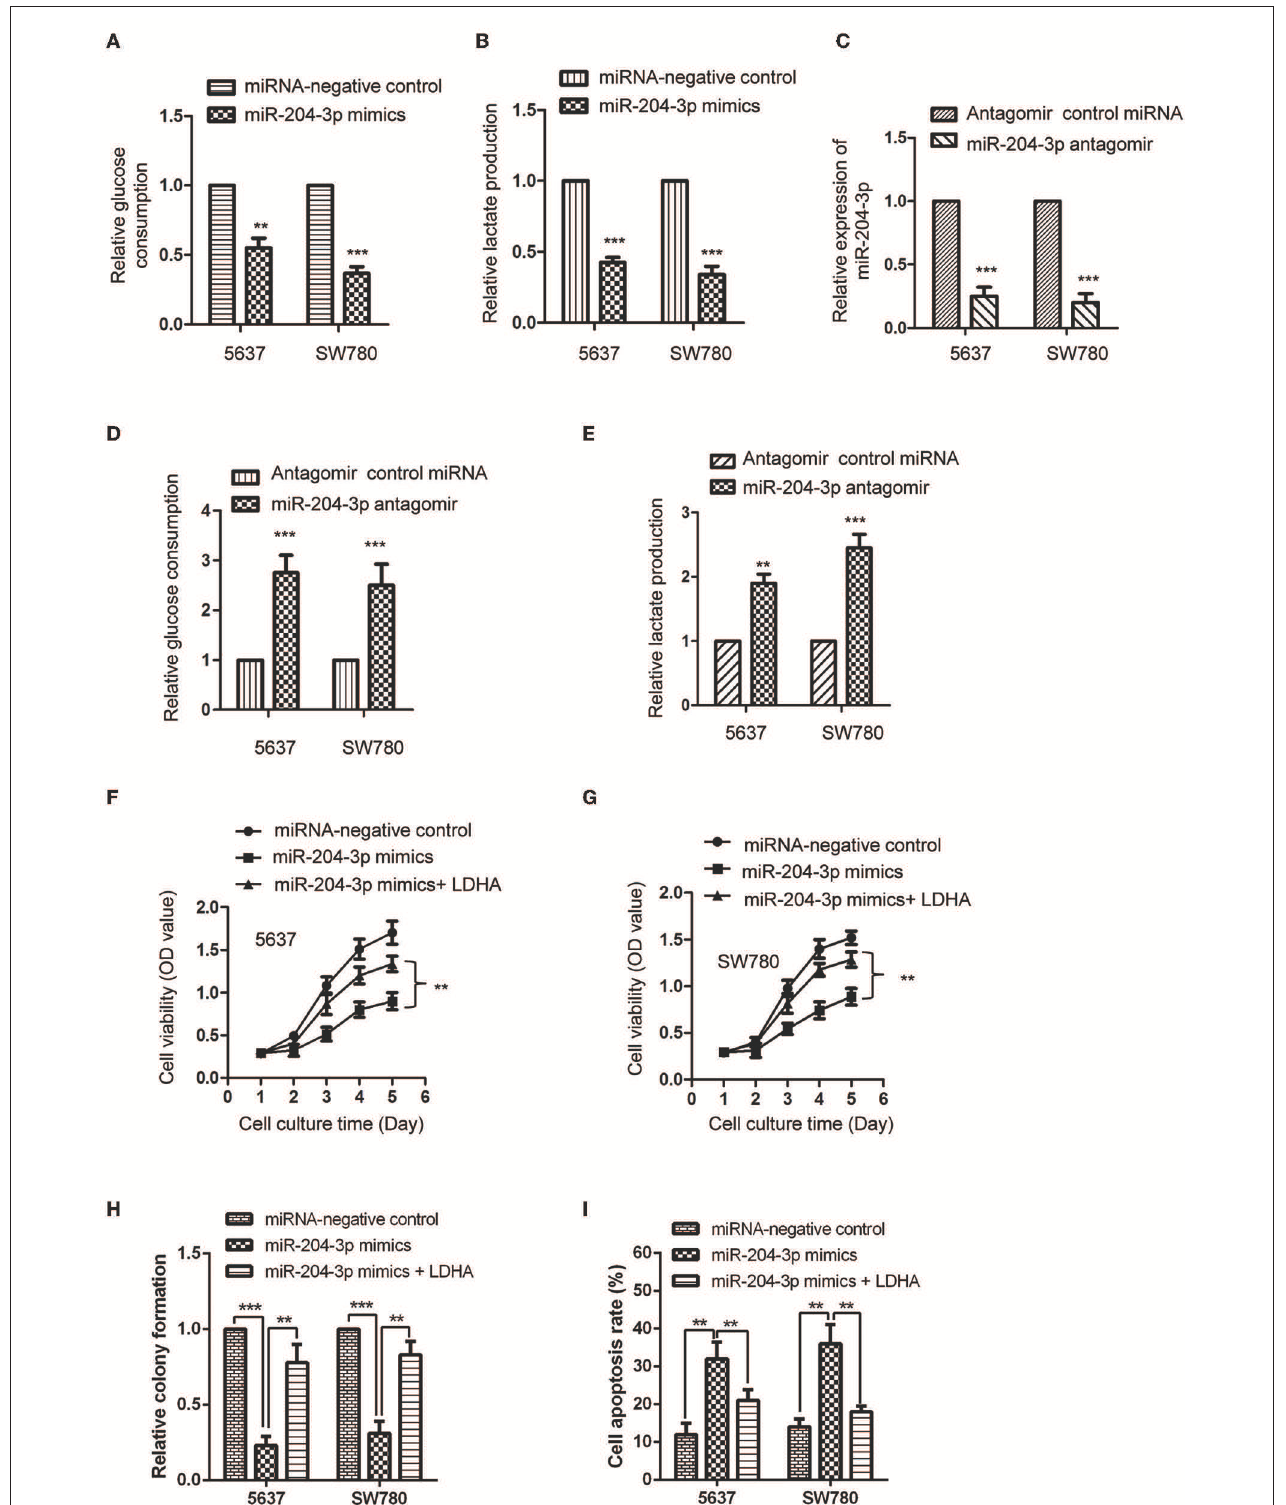
FIGURE 4 | MiR-204-3p modulated the glycolysis of bladder cancer cells. (A,B) SW780 and 5637 cells were transfected with control miRNA or miR-204-3p mimics, and the glucose consumption and lactate production were measured. (C) The expression of miR-204-3p in SW780 and 5637 cells with antagomir control miRNA or